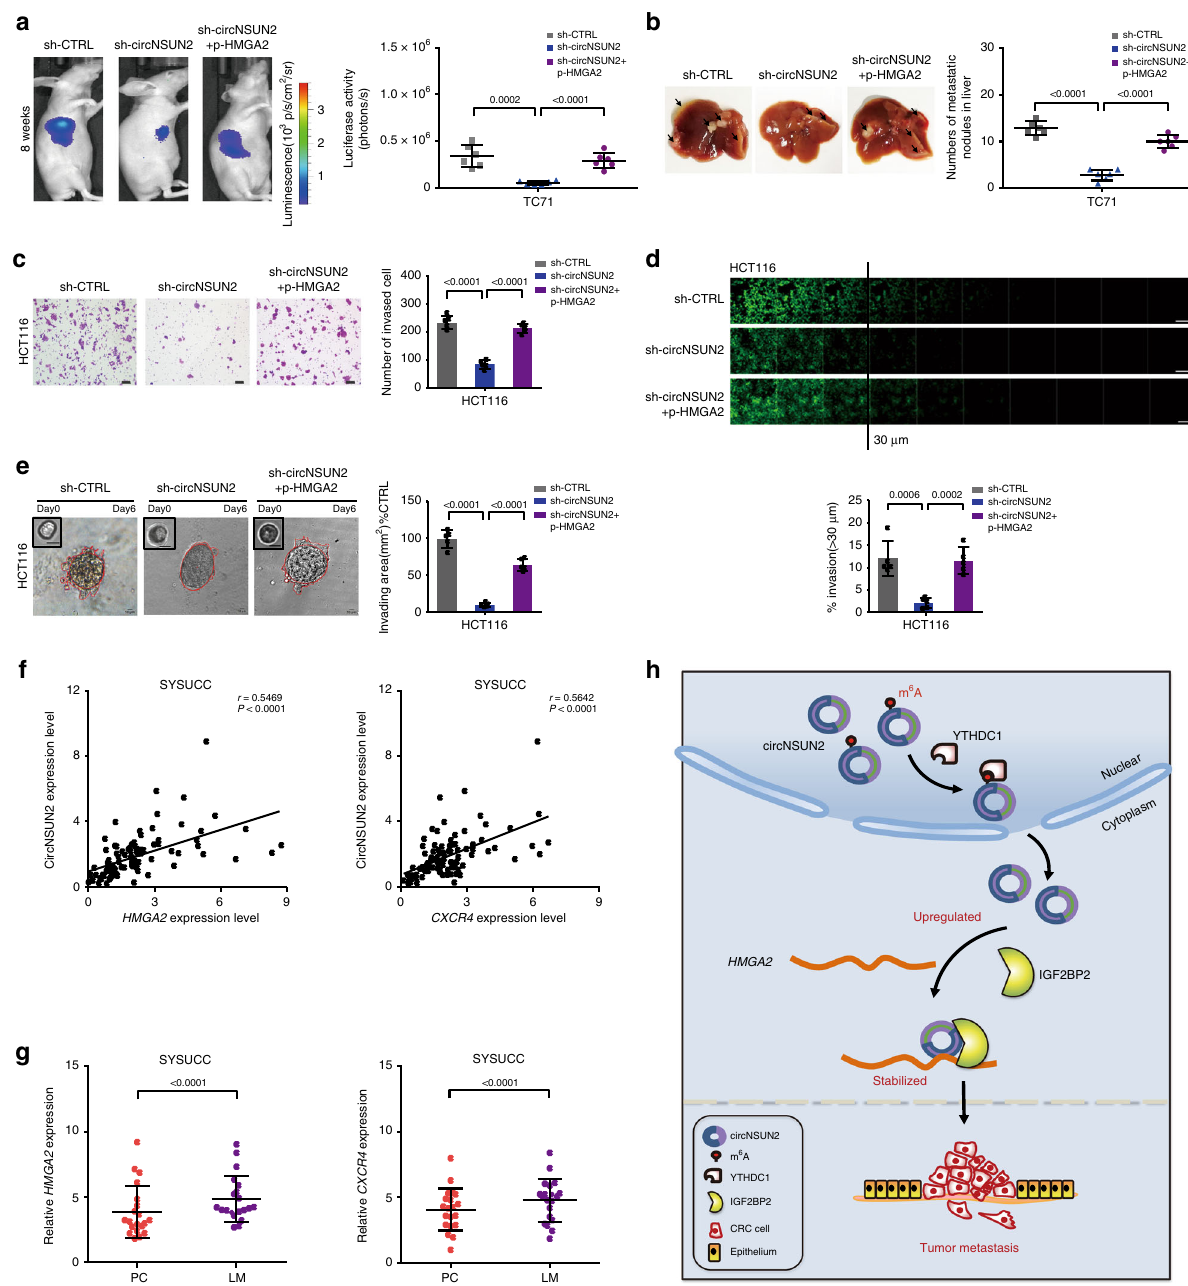
Fig. 7 CircNSUN2 promotes LM metastasis of CRC through HMGA2 pathway. a , b Decreased tumor metastasis formed in the livers of mice through the inferior hemispleen implantation of circNSUN2-konckdown TC71 PDX cells was rescued by overexpression of HMGA2. a Left, representative bioluminescent images of livers for each experimental group at 8 weeks. Right, statistical analysis of bioluminescent tracking plots. The P values were determined by a two-tailed unpaired Student ’ s t test. b Left, representative liver. Right, the number of metastatic nodules formed in the livers of mice for each group ( n = 6 mice/group). The P values were determined by a two-tailed unpaired Student ’ s t test. c − e Transwell assay ( c ), inverted invasion assay ( d ) and 3D multicellular tumor spheroids invasion assay ( e ) showing that decreased cell invasion in circNSUN2 knockdown HCT116 cells was rescued by overexpression of HMGA2. Scale bar, 100 µ m ( c ), 100 µ m ( d ) and 10 µ m ( e ). Data represent mean ± S.D. from fi ve independent experiments; dot plot re fl ects data points from independent experiment. The P values were determined by a two-tailed unpaired Student ’ s t test. f Left, circNSUN2 expression showing positively correlated with HMGA2 expression in CRC patients derived from SYSUCC. Right, circNSUN2 expression showing positively correlated with CXCR4 expression in CRC patients derived from SYSUCC. The P values were determined by Pearson correlation analysis. g qRT – PCR analysis for the RNA expression of HMGA2 and CXCR4 in 20 pairs of primary colorectal cancer (PC) and matched liver metastasis (LM) surgically obtained from the same patients. Data represent mean ± S.D., the P values were determined by a two-tailed paired Student ’ s t test. h A proposed model for the regulatory landscape of the circNSUN2/IGF2BP2/ HMGA2 signaling axis in promoting the metastasis of CRC. Source data are provided as a Source Data fi